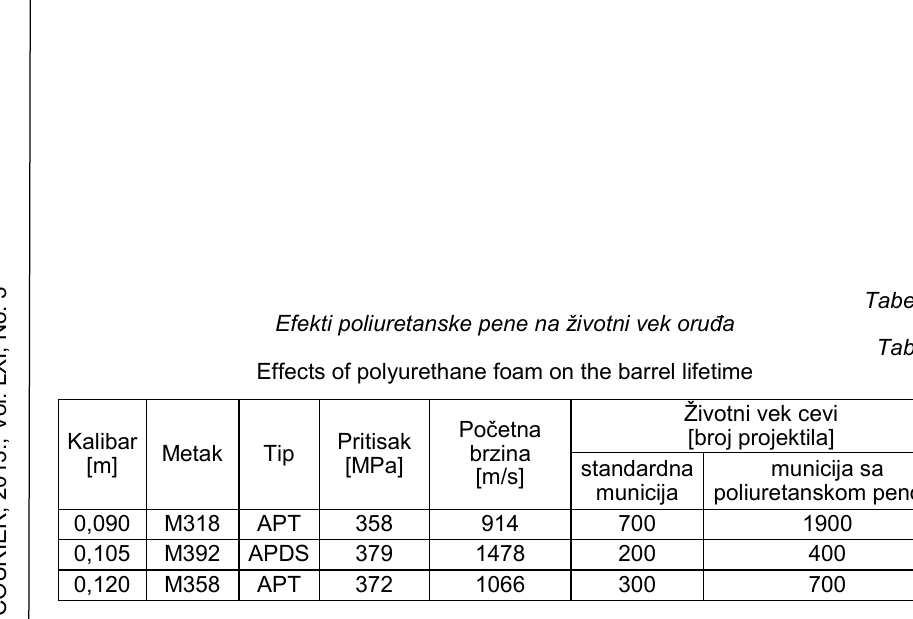
Životni vek cevi [broj projektila] Kalibar